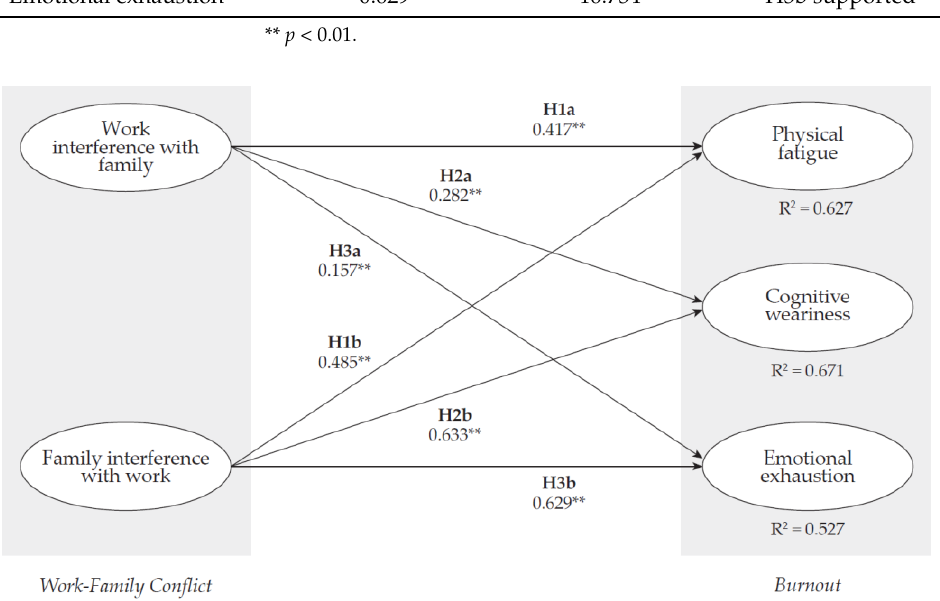
Figure 2. Standardized structural path coefficients. Notes: N = 1044; ** p < 0.01. Table 5. Standardized path coefficients for the structural model (overall